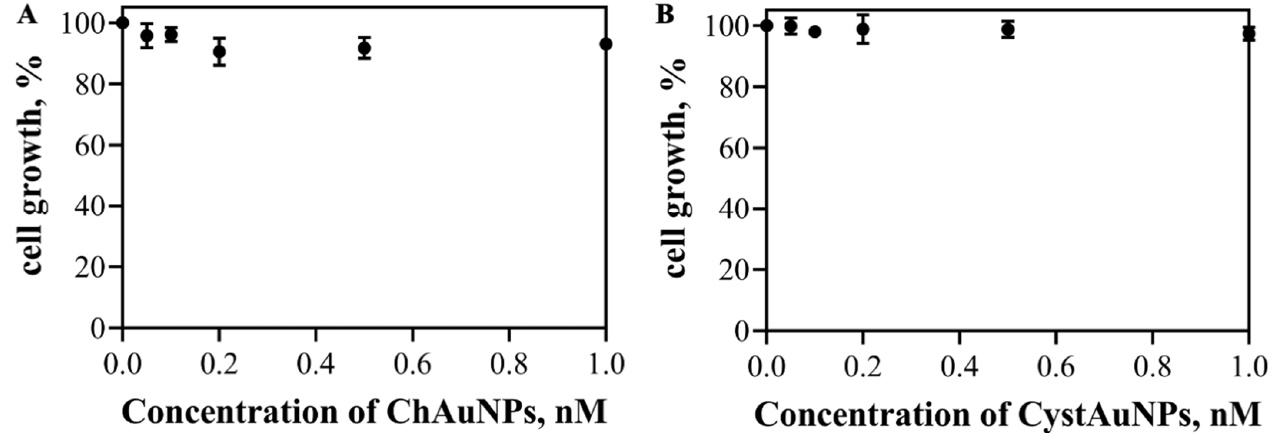
Figure 6. Effect of ChAuNPs ( A ) and CystAuNPs ( B ) on the cell growth of pancreatic cancer BxPC3 cells.